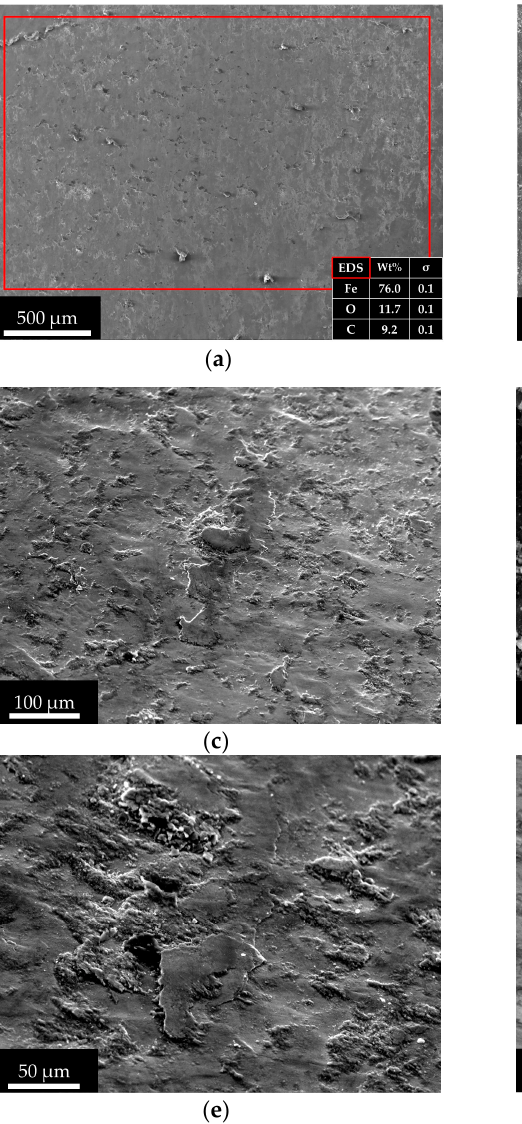
10 of 17 Figure 6. Coefficient of friction (black points) and specific wear rate (grey points) as a function of the worn surface hardness of bainitic structures formed at 220 °C after austenitization at 860 °C for 20 min (circles) and 900 °C for 30 min (triangles); martensitic structures formed after austenitization at 900 °C for 30 min, quenching, and tempering at 280 °C for 2 h (squares) in Nanobain bearing steel; and bainitic and tempered martensitic structures obtained in a 1C-2.3Si, as reported elsewhere [24]. Rolling/sliding results indicate that wear resistance of nano-scale bainitic structures outperform tempered martensite in the same steel. The three studied structures of Nanobain bearing steel showed equivalent performance to former Nanobain grades [23,24,27]. Even though it was not possible to improve upon Nanobain performance, it is noteworthy that the new material combined the same performance with improved hardness. Similarly, an unexpected lack of correlation of wear resistance with initial hardness was formerly observed on dry-sliding wear of carbide-free bainitic steels elsewhere [38–40], and more recently on nanostructured bainite and tempered martensite of high carbon high silicon steels after dry reciprocating-sliding wear tests conducted at low frequencies against an alumina ball [24]. It was suggested that the highly-refined microstructure and the strain- induced transformation of austenite films increases further surface layer hardening and resistance to